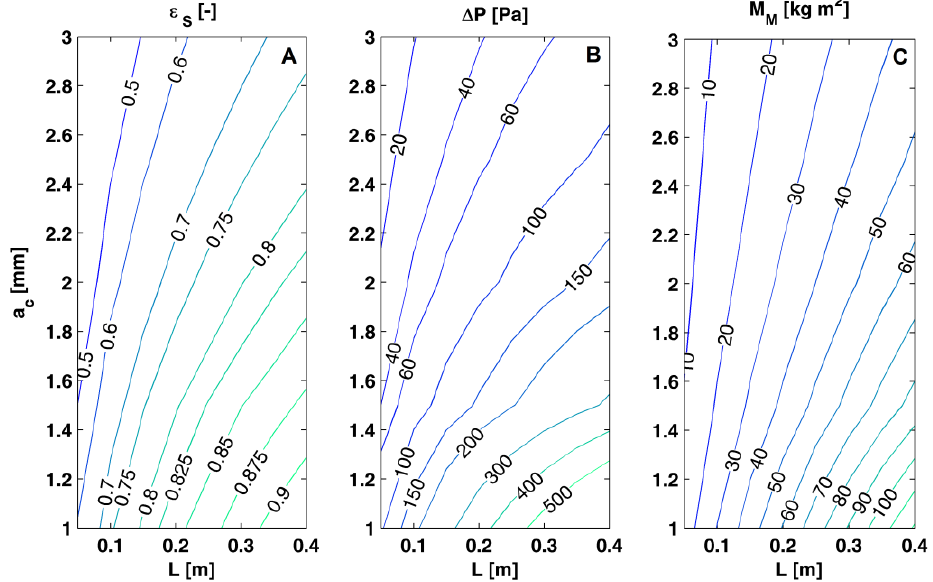
Figure 10. Sensible effectiveness, pressure drop and amount of matrix material for different L and a c ( b c / a c = 2, T su,in = 10 °C, T ex,in = 30 °C, X su,in = 3.7 g·kg −1 , X ex,in = 7.7 g·kg −1 , s =0.05 mm, N =10 rev min -1 , v